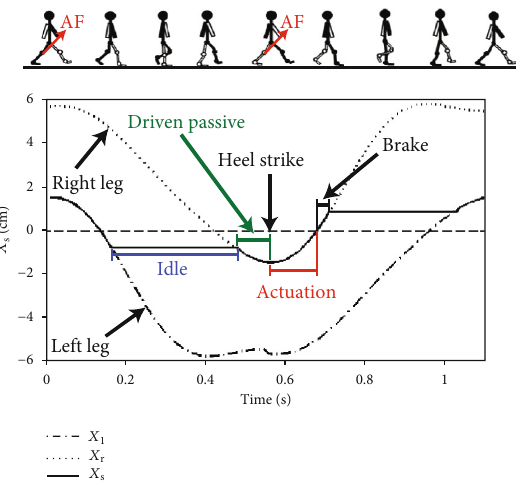
Figure 11: Illustrations of the motion projections of the mapped coordinate for the cases in which the soft exoskeleton is worn and not worn while walking. The assistive forces were provided during the preswing phases for each